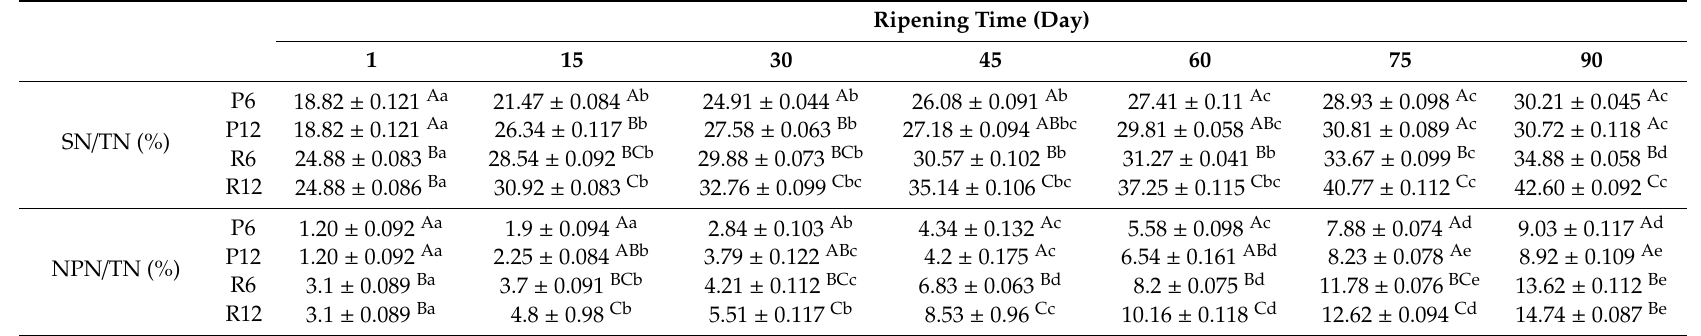
Table 3. Classical nitrogen fractions of Motal cheese during the 90-day ripening